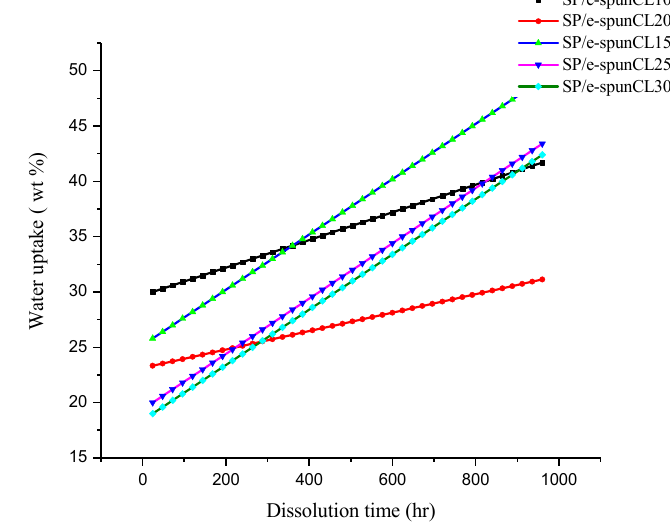
Figure 8. Long term stability effect in hydrated conditions of SP/e-spunCL nanocomposite membranes.